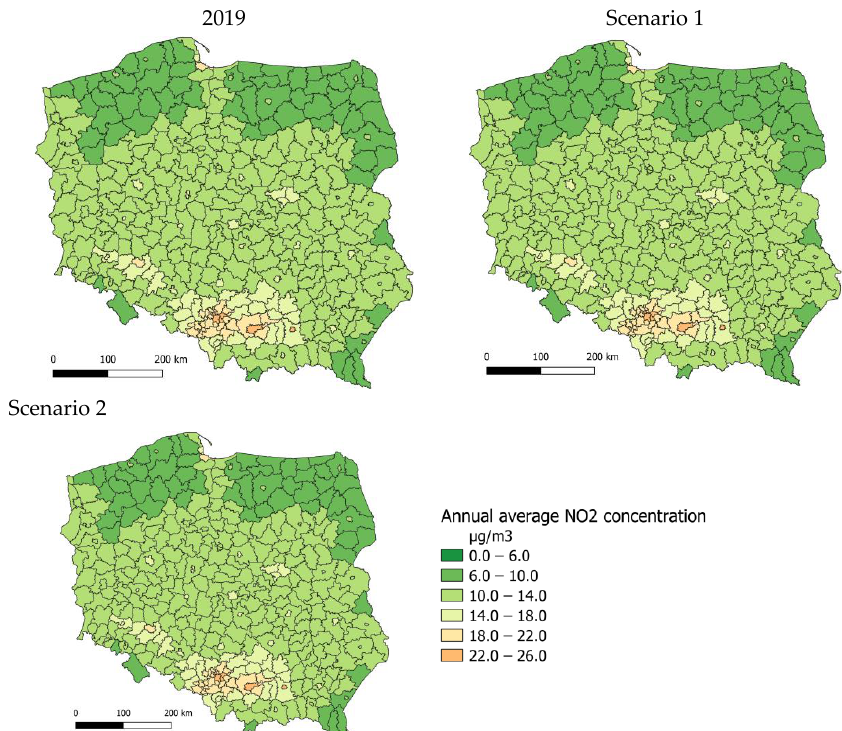
Figure 5. Spatial distribution of annual average NO 2 concentrations in 2019 and for scenarios 1 and 2 (county average).